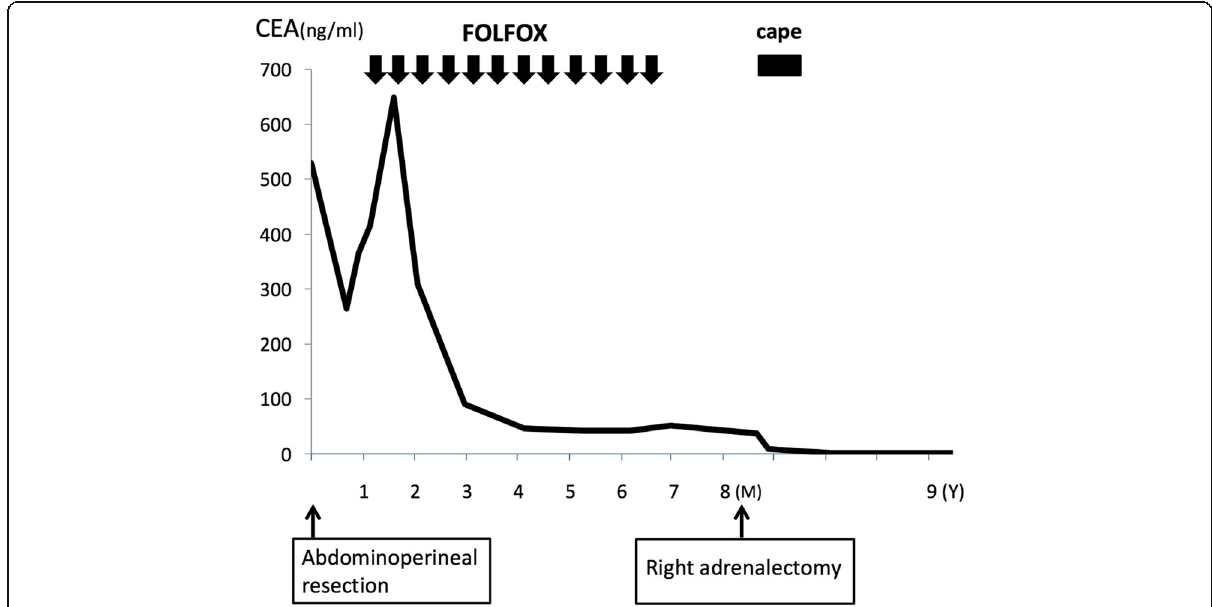
Fig. 2 The clinical course of Case 1. Vertical axis: CEA (ng/ml). Horizontal axis: time elapsed. M month(s). Y year(s). FOLFOX infusional 5-fluorouracil, leucovorin, oxaliplatin. Cape